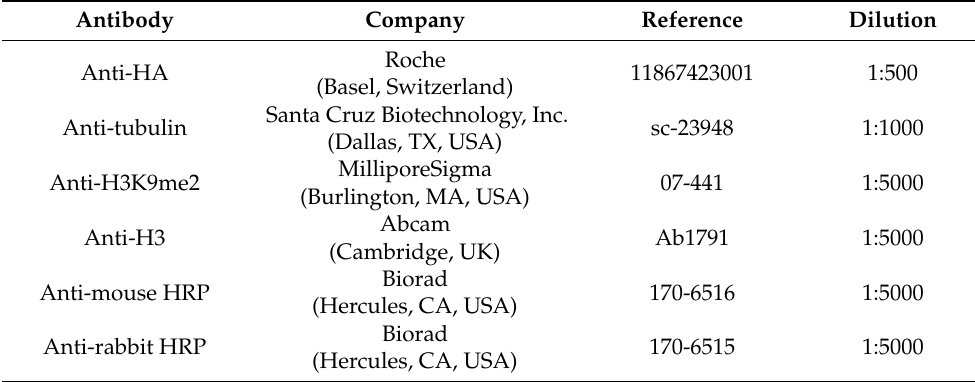
Table 1. List of antibodies used for